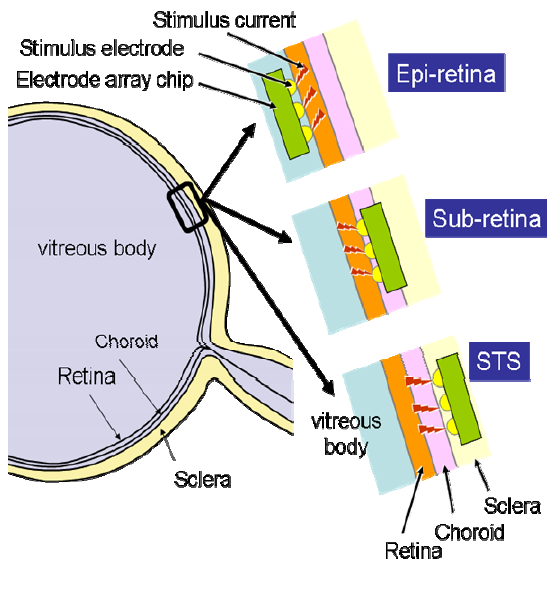
Figure 6. Intraocular retinal